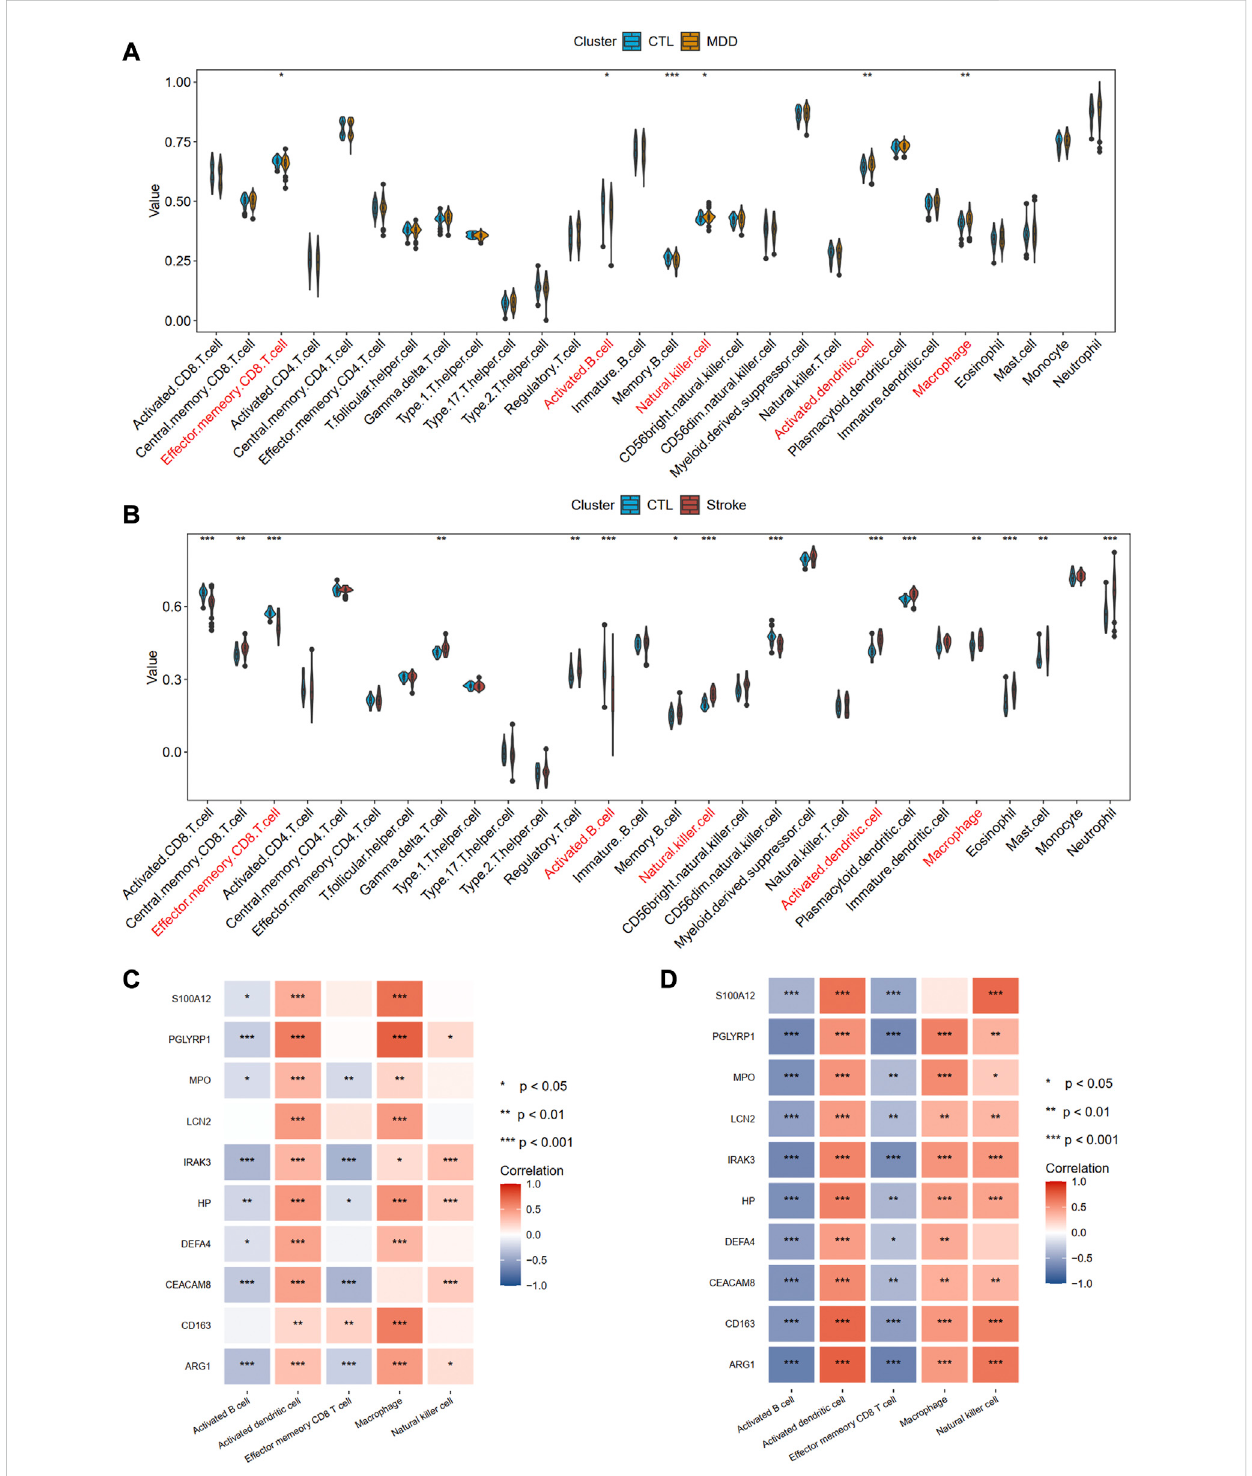
FIGURE 10 Identi fi cation of common immune cells between MDD and IS. (A) The abundance of the immune cell in MDD using the ssGSEA method. (B) The abundance of the immune cell in IS using the ssGSEA method. The immune cells with red color indicate the signi fi cantly common immune cells. (C) and (D) A heat map visualized the correlations between common immune cells and shared hub genes. Signi fi cance level was denoted by * p -value < .05, ** p - value < .01, *** p -value <